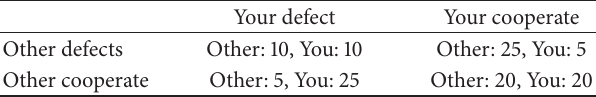
Table 1: Payoff matrix of Prisoner’s